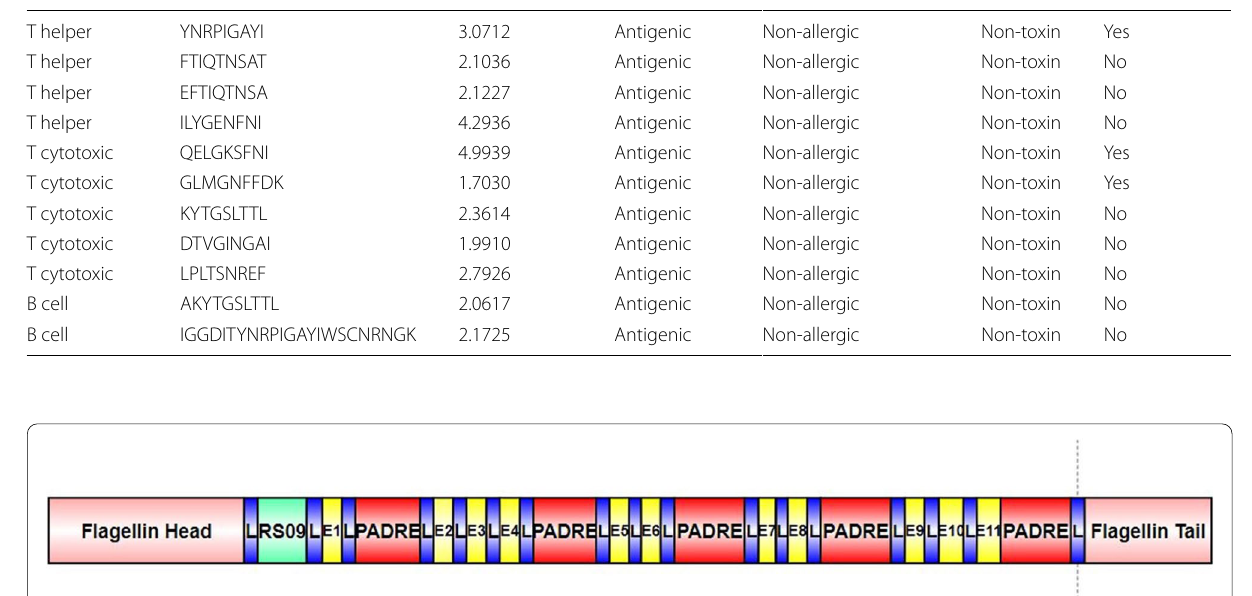
Fig. 1 Map of the vaccine construct: E1 to E11 are the selected epitopes. L is a GGS linker. Flagellin head and tail are shown at the N and C terminal ends. RS09 and PADRE sequence are placed in between E1 and E11